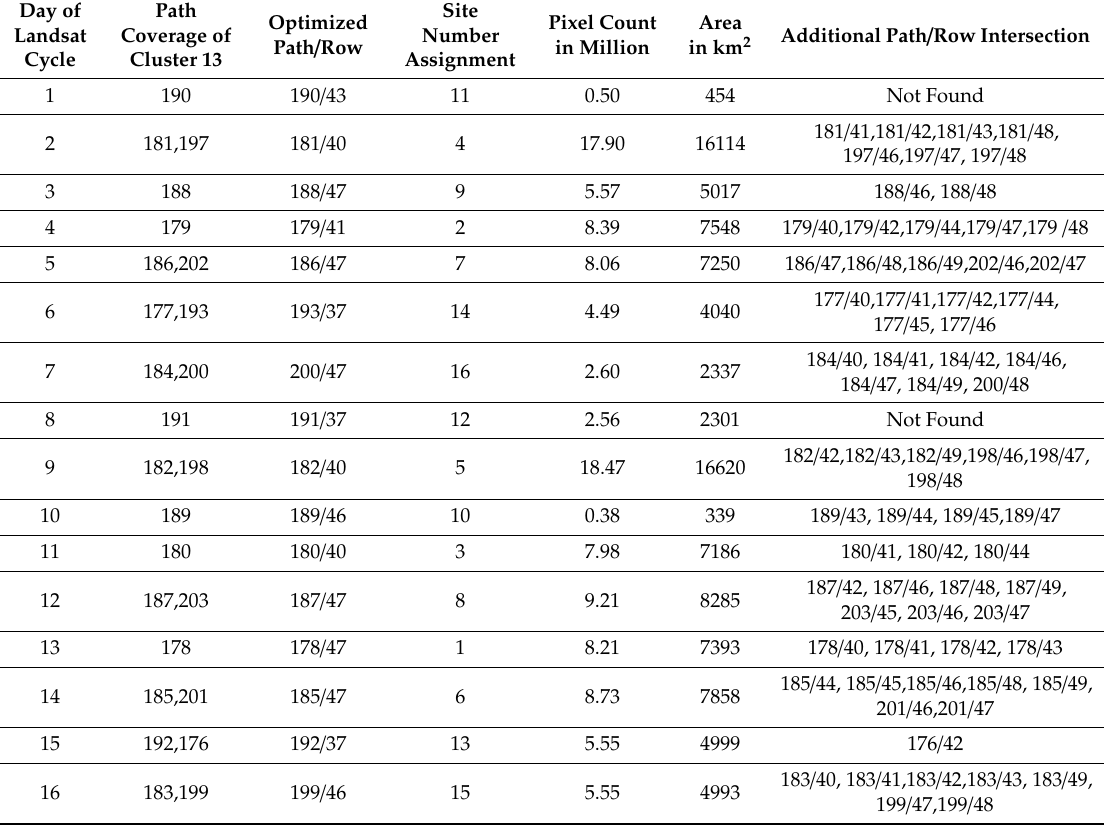
Table 2. Path coverage of Cluster 13 and optimized WRS-2 path / row